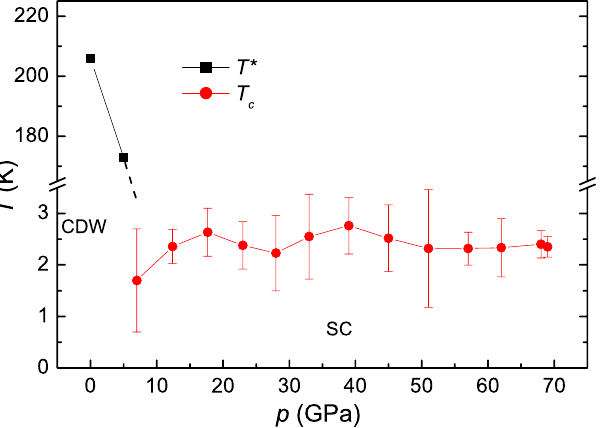
Figure 5. Temperature versus pressure phase diagram of NbTe 4 . T * and T c denote the resistivity anomaly temperature and the superconducting transition temperature,